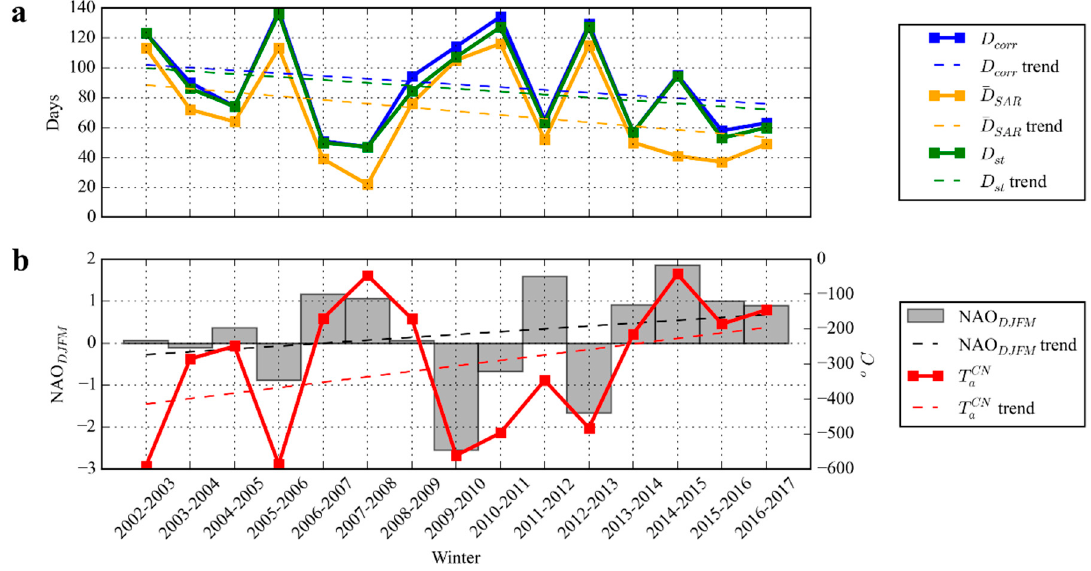
Figure 15. The interannual variability of the various ice season duration types ( a ), NAO winter index, and cumulative negative air temperature during the 15 winter seasons ( b ) in 2002–2017.